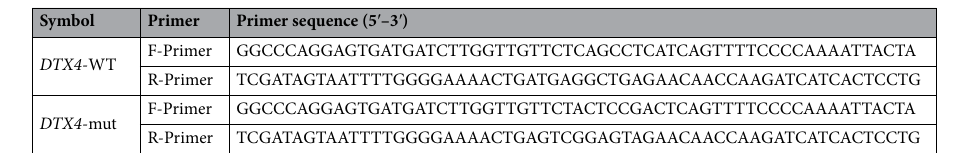
Symbol Primer Primer sequence (5 ′ –3 ′ )